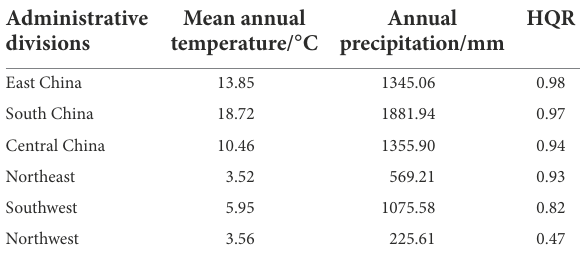
TABLE 1 The HQR and mean annual temperature – annual